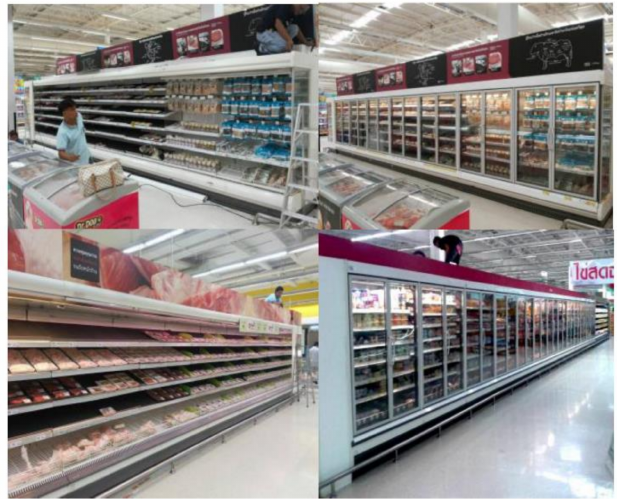
Figure 2. Installation of Low-E glass door for store No.1 (R22).